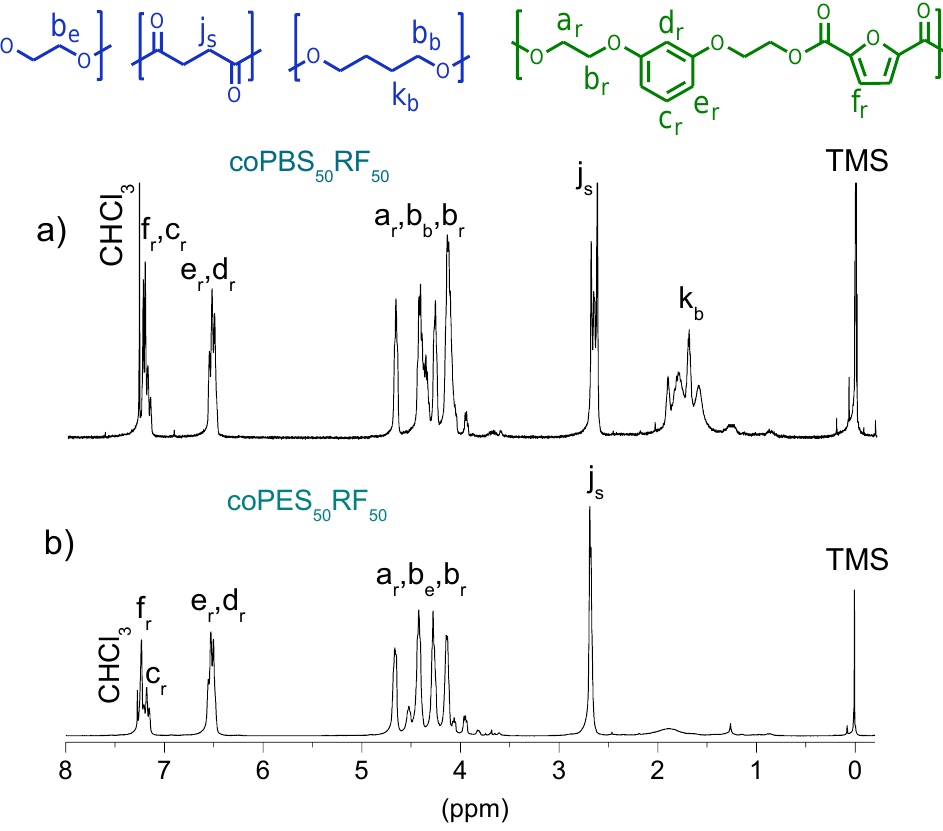
Figure 6. 1 H NMR spectra of resorcinol-containing succinate-furanoatecopolyesters. ( a ) co PBS 50 RF 50 ; ( b ) co PES 50 RF 50 .